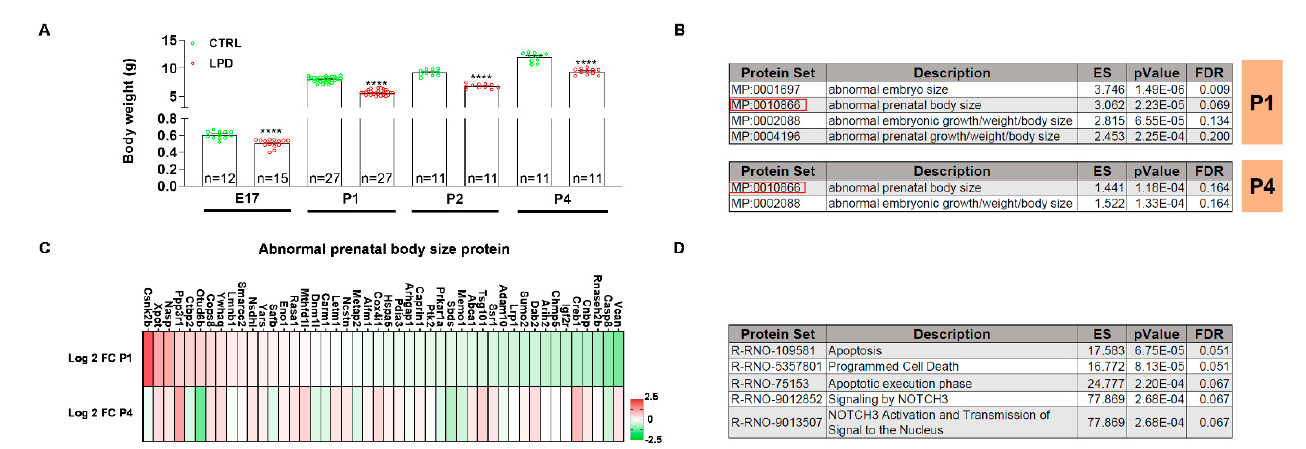
Figure 2. The microglial proteome reflects the low body weight observed in LPD animals early during their development. ( A ) Body weight (g) of CTRL and LPD animals at the embryonic stage (E17) and the postnatal days P1, P2, and P4. Data (Mean ± SEM), **** p < 0.0001 vs. CTRL. ( B ) ORA analysis of differentially expressed proteins between CTRL and LPD at P1 and P4 performed against the mammalian phenotype database. ( C ) Log2 fold change (FC) of proteins associated with the abnormal prenatal body size protein set. Reported Log2 FCs were calculated for the following comparisons LPD P1 vs. CTRL P1 and LPD P4 vs. CTRL P4. Upregulated proteins are depicted in red and downregulated proteins in green. ( D ) ORA analysis of proteins associated with the abnormal prenatal body size protein set against the Reactome pathway database.